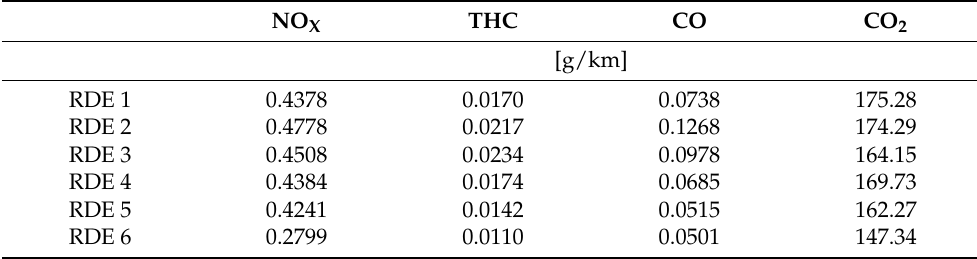
Figure 7. NO X ( a ), CO ( b ), THC ( c ) and CO 2 ( d ) pollutant emissions. Table 6. RDE pollutants emissions per kilometer.